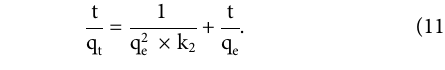
and q are the amounts of quetiapine (mg g − 1 ) adsorbed where q e t at the equilibrium and at time t (min), respectively. Also, k 1 is the rate constant of adsorption (min − 1 ). The values of k 1 for quetiapine adsorption on the MIP were de fi ned by the plot of − q ) against t. The values of k log ( q 1 and q e are presented in e t Also, the second-order kinetic model is expressed as follows: The second-order constant k 2 (g mg − 1 min − 1 ) and the equilibrium adsorption capacity q e could be determined